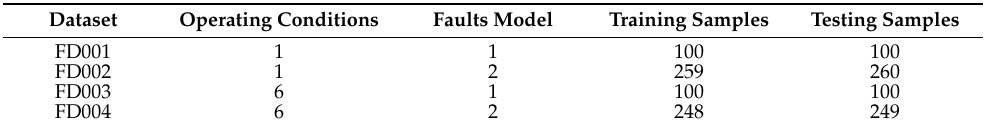
Table 3. Commercial Modular Aero-Propulsion System Simulation (C-MAPSS) dataset details.